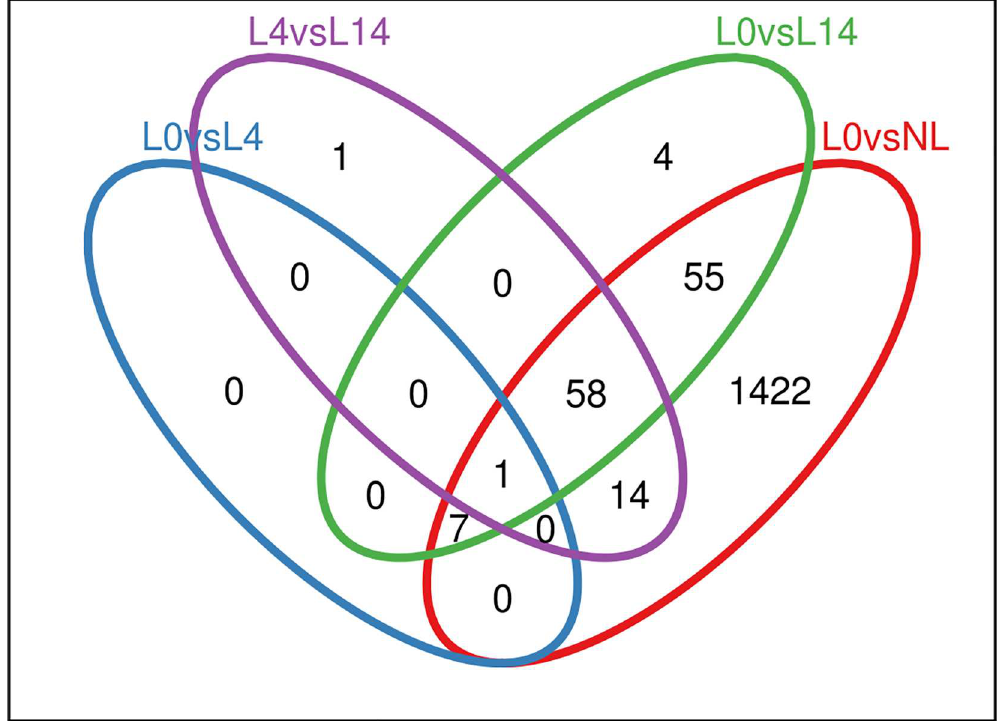
Fig 1. Venn diagram indicating the overlap between differentially expressedgenes in each contrast. Blue: lesionaluntreated versus lesionalday 4. Purple: lesionalday 4 versus lesionalday 14. Green: Lesionaluntreated versus lesionalday 4. Red: Lesionaluntreatedversus nonlesional